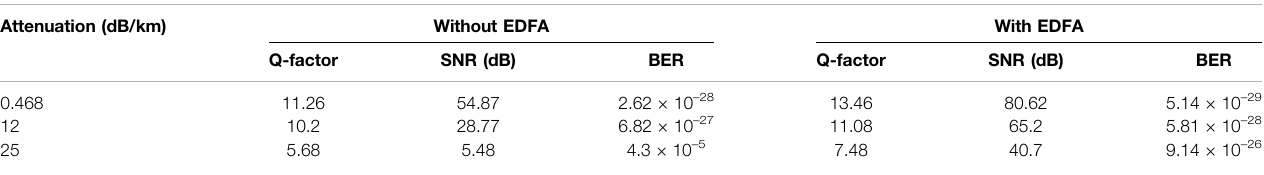
TABLE 3 | Output values of different parameters at 1,000 m link distance. Attenuation